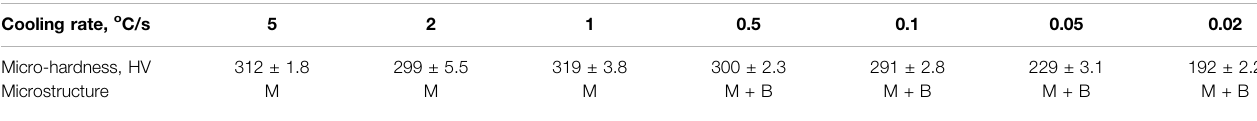
TABLE 5 | Micro-hardness and microstructure of experiment steel when cooled down at different rates. Cooling rate, o C/s